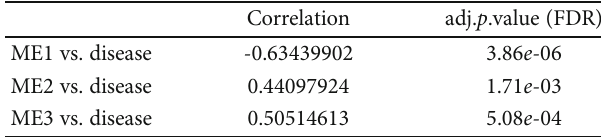
Table 1: The correlation analysis for disease and gene modules (ME1, ME2, and